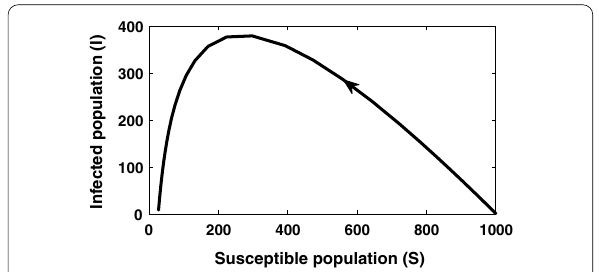
Fig. 6 Phase plane analysis of basic SIR model. Simulation is done for initial values S = 1000, I = 1, R = 0 and parameter values β = 1.5 × 10 − 3, γ = 0.4